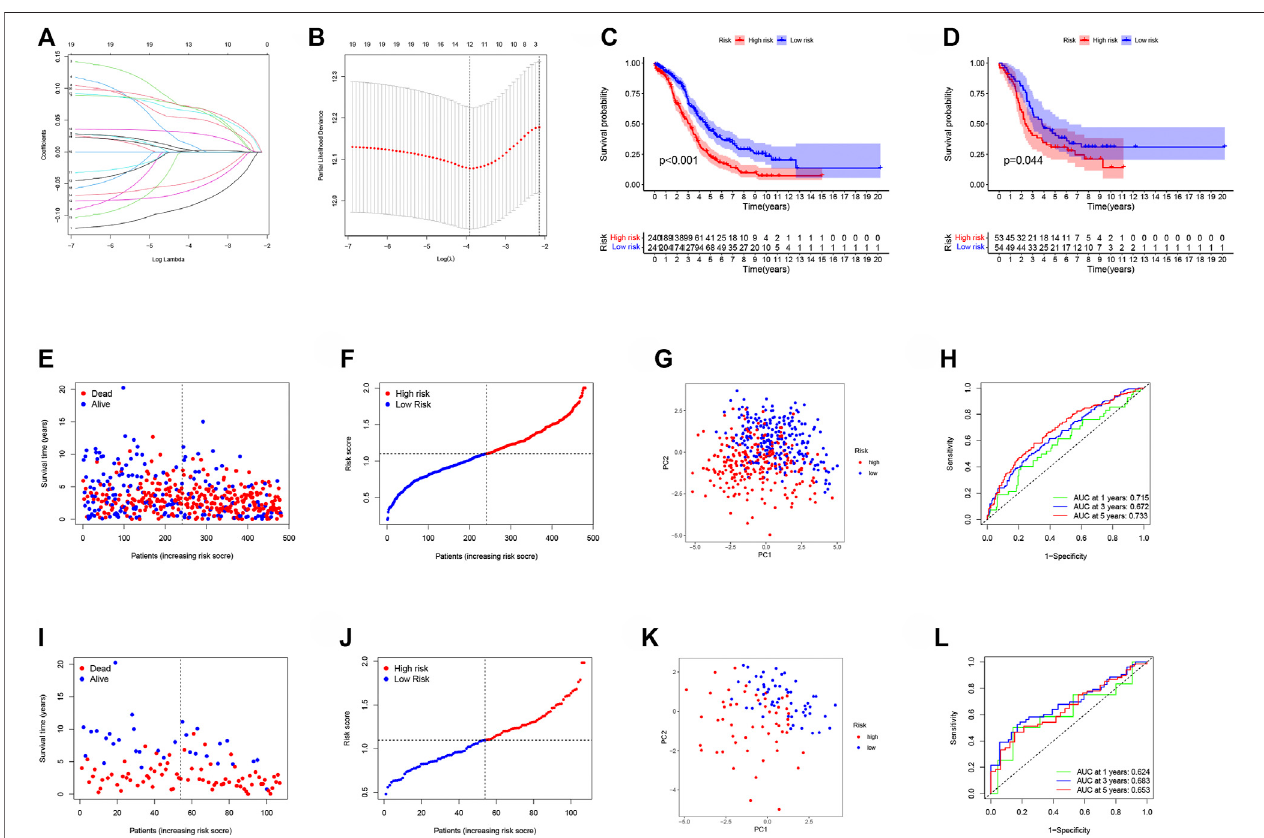
FIGURE 6 | Development and veri fi cation of risk signatures associated with NMRGs in OC. (A) Cross-validation for tuning parameter selection in the lasso regression. (B) Validationwasperformedfortuningparameterselectionthroughtheleastabsoluteshrinkageandselectionoperator(LASSO)regressionmodelforoverall survival (OS). (C) Training cohort, Kaplan-Meier survival analysis of high and low RS subgroups. (D) Validation cohort, Kaplan-Meier survival analysis of high and low RS subgroups. (E) Training cohort, patient ’ s survival status. (F) Training cohort-RS distribution ofpatients. (G) Training cohort-PCA analysis. (H) Training cohort-plots of the AUC for time-dependent ROC performance. (I) Validation cohort, patient ’ s survival status. (J) Validation cohort-RS distribution of patients. (K) Validation cohort- PCA analysis. (L) Validation cohort-plots of the AUC for time-dependent ROC performance.